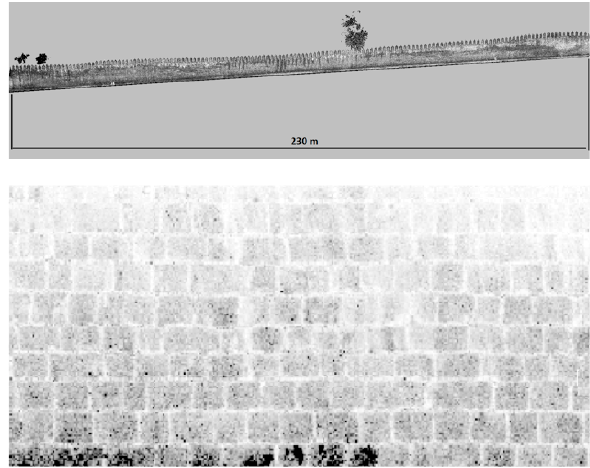
Figure 3. Point cloud of the vault (left) and intensity image Figure 5. Point cloud collected with the MLS Lynx Mobile (right). Mapper system to validate the algorithm (top) and an intensity image created from this point